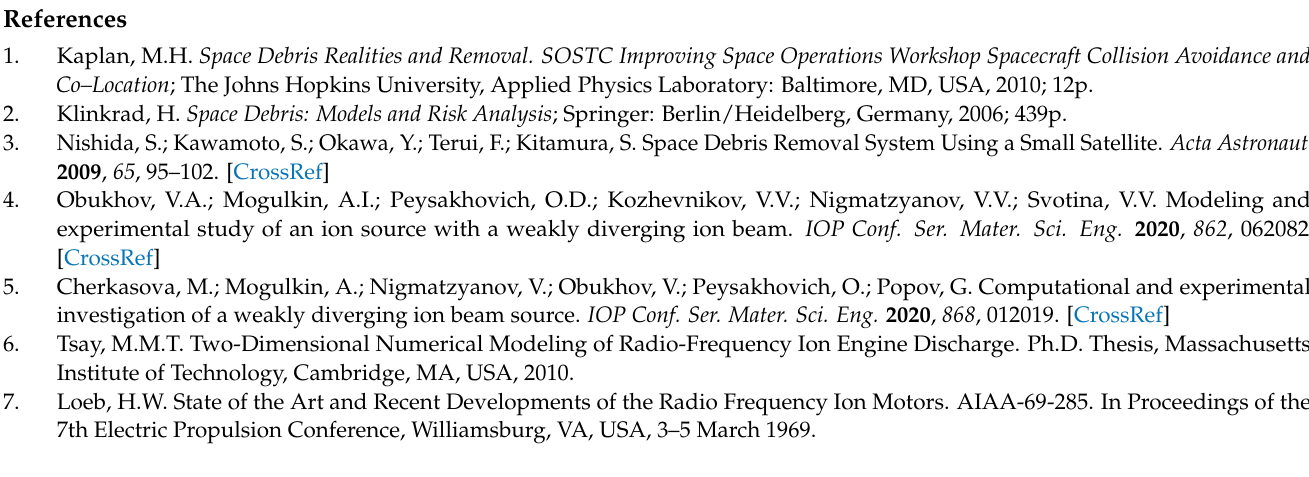
Figure 12. Radial distribution of the extracted ion current density at the xenon flow rate of 1 mg/s. Analysis of the above dependences shows that the use of an internal antenna leads to the maximum increase of the extracted ion current, if compared to the external lateral configuration of the antenna turns, and to its shift from the discharge chamber walls to the central region. Such a change in distribution allows us to predict an improvement in the RF ion injector integral characteristics.